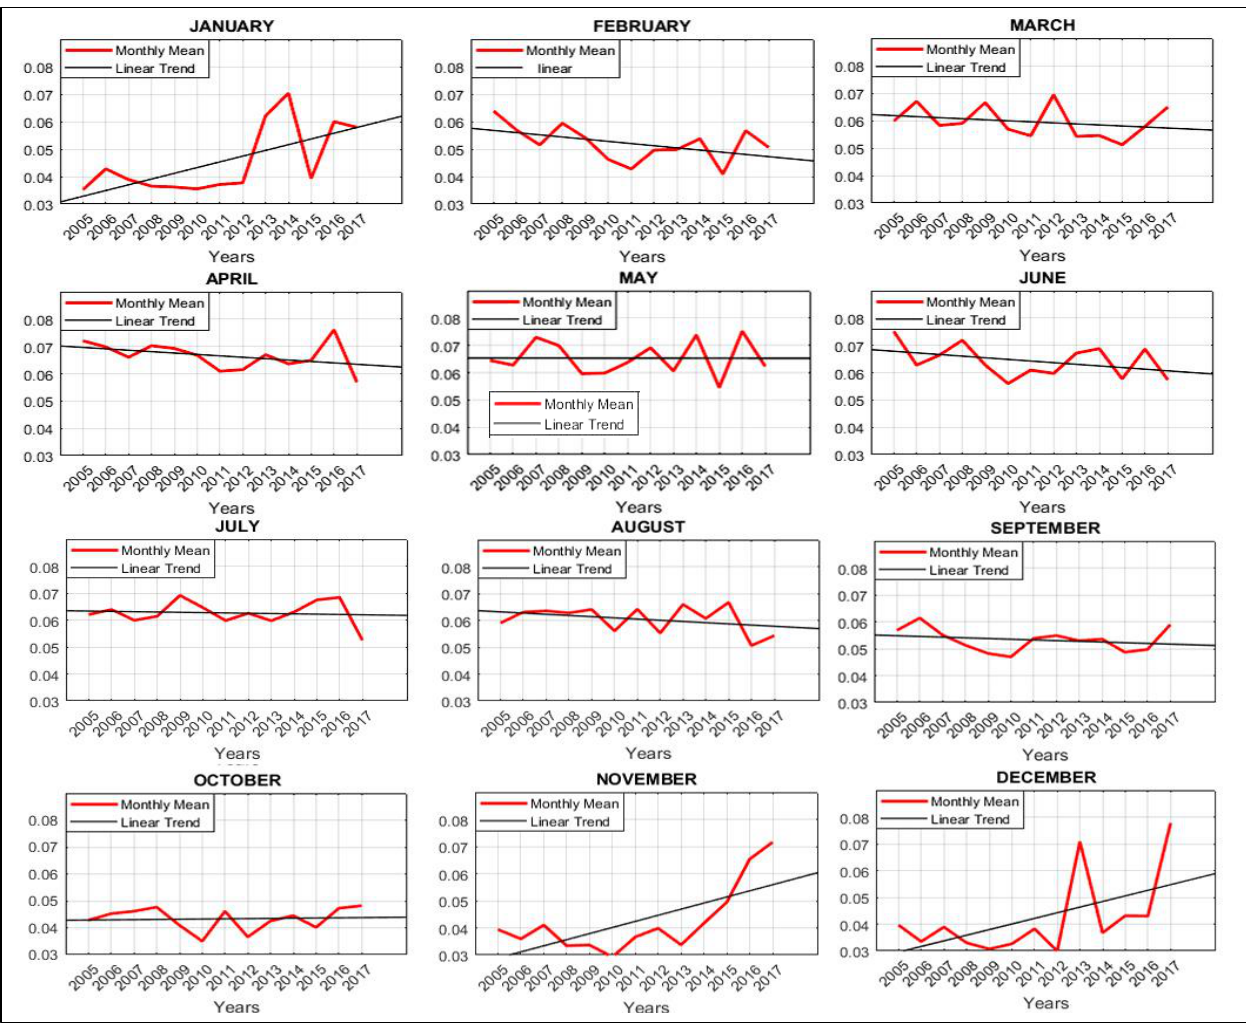
Figure 4. Year wise (2005 - 2017) monthly mean of each of twelve months along with standard deviation is observed. Linear trend lines for each month has also been plotted to show the chronological variability of absorbing aerosol over the study